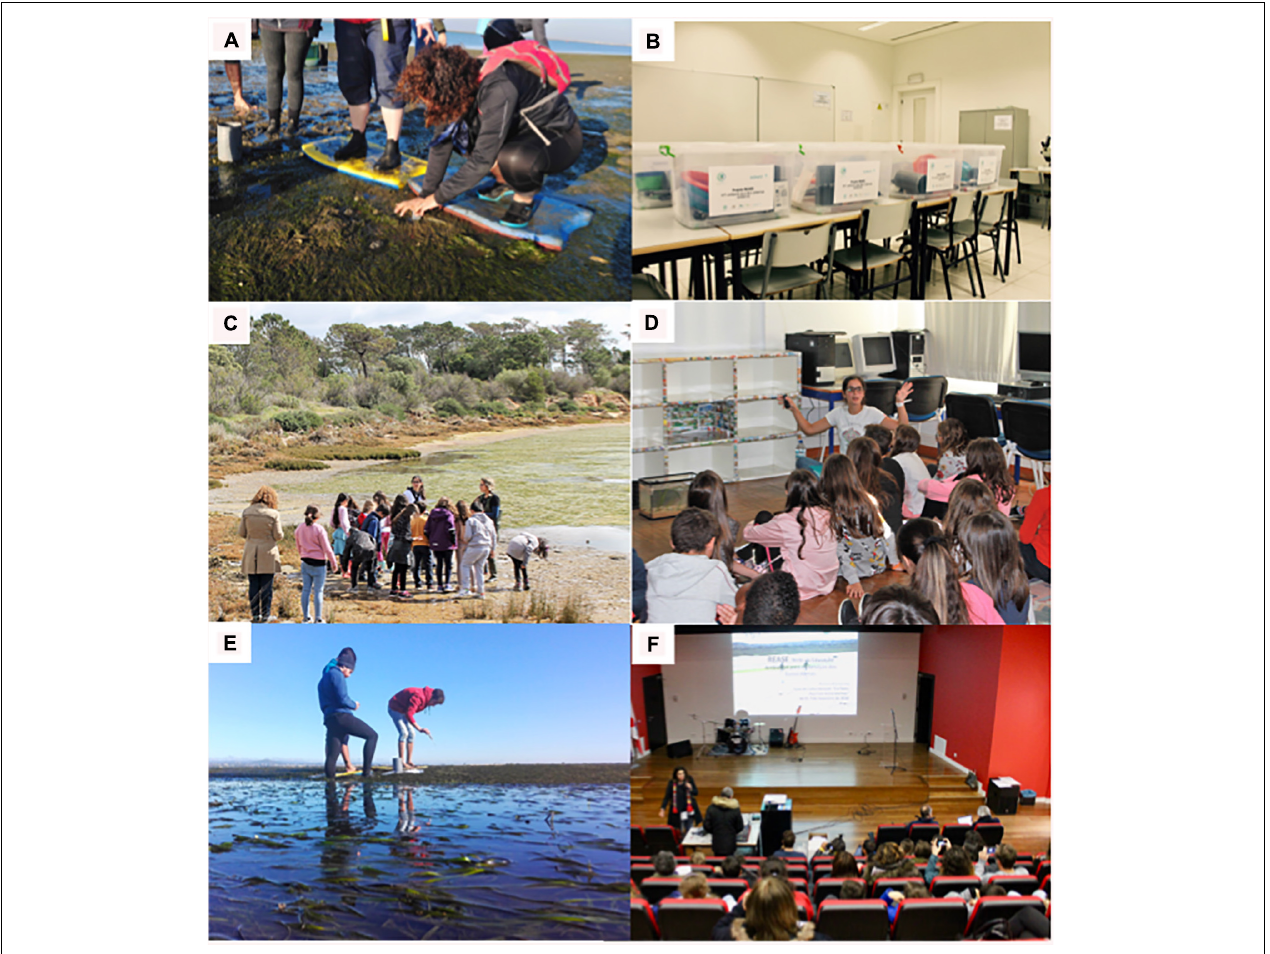
FIGURE 2 | REASE activities for formal education includes (A) continuing training for K-12 teachers on ecosystem services (ES); (B) an incubator of innovative projects on ES, such as mapping the blue carbon in the Algarve that includes the delivery of a field kit; (C) field trips with schoolchildren; (D) using storytelling to educate on ES using local examples; (E) researcher for one day program; and (F) public presentations. All identifiable individuals have delivered a written consent for the publication of the